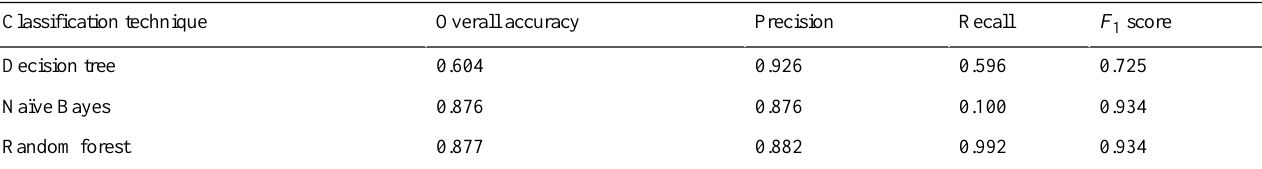
Table 3. Classification of the Repeatable Battery for the Assessment of Neuropsychological Status score performance measures when applied to the evaluation data set (training set size=2152; evaluation set